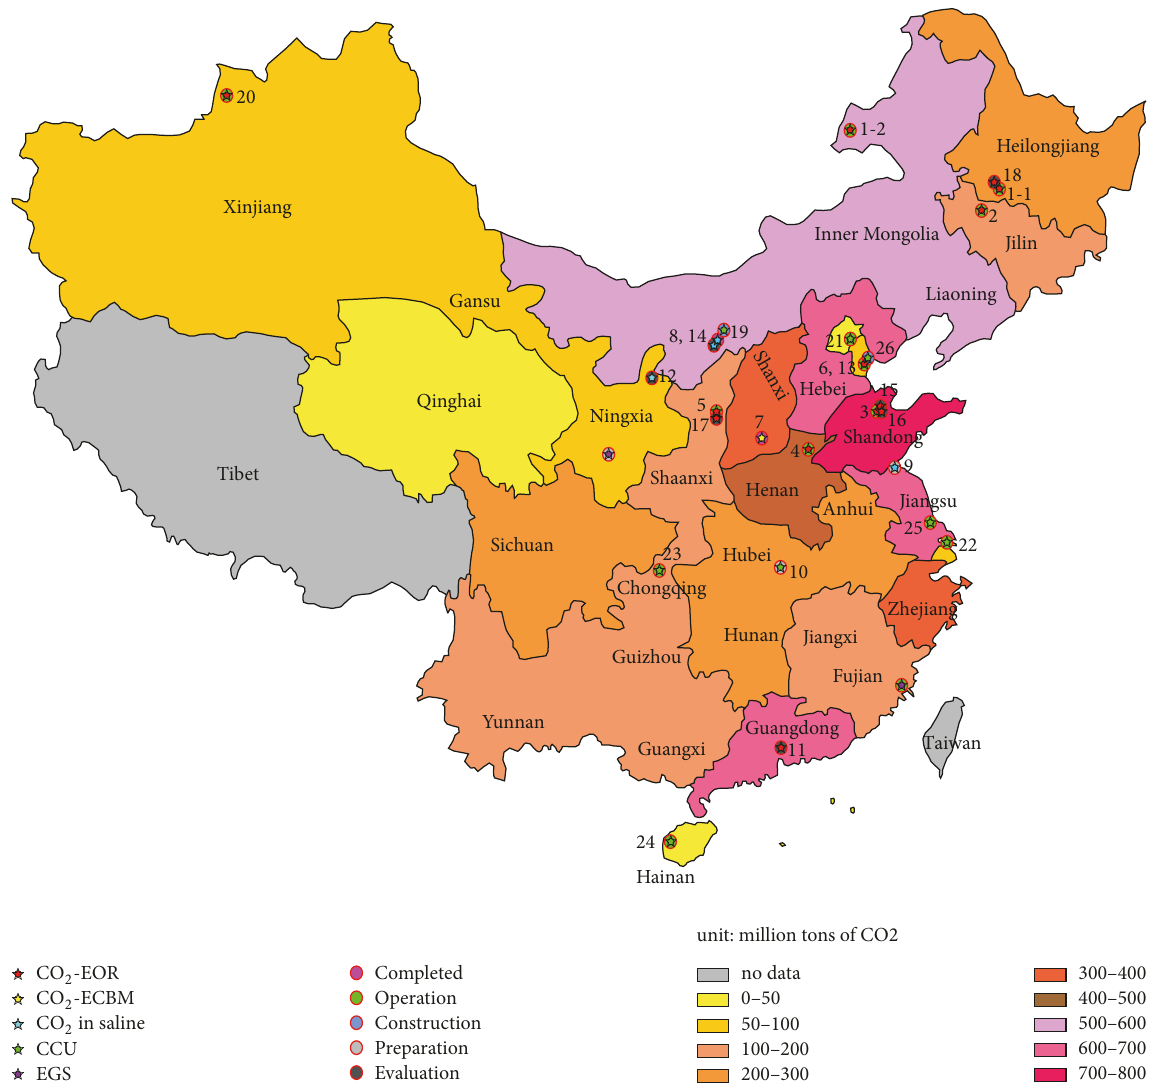
Figure 7: Distribution of CCUS engineering projects in China excluding the South China Sea Islands (numbers defined in Table 3) superimposed on the provincial CO 2 emission map for the year 2010 (from [34]).